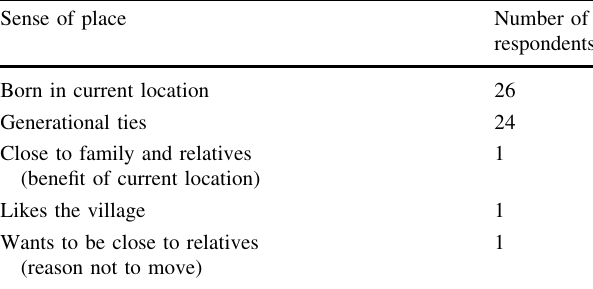
Table 2 Benefits of living in the current location of the Akuressa area in Sri Lanka